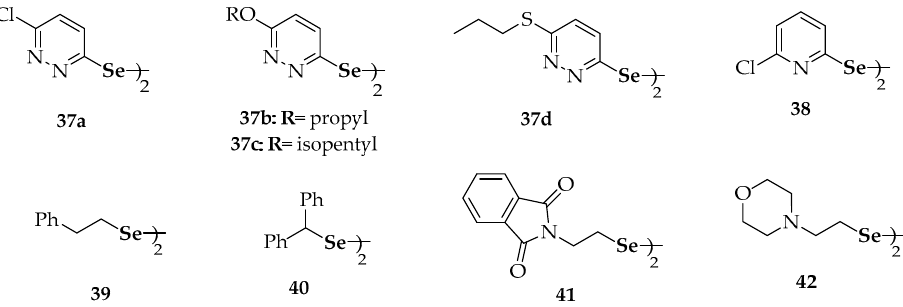
Figure 4. Synthetic diselenides with antiproliferative studies [52,56,66,67,76–79].